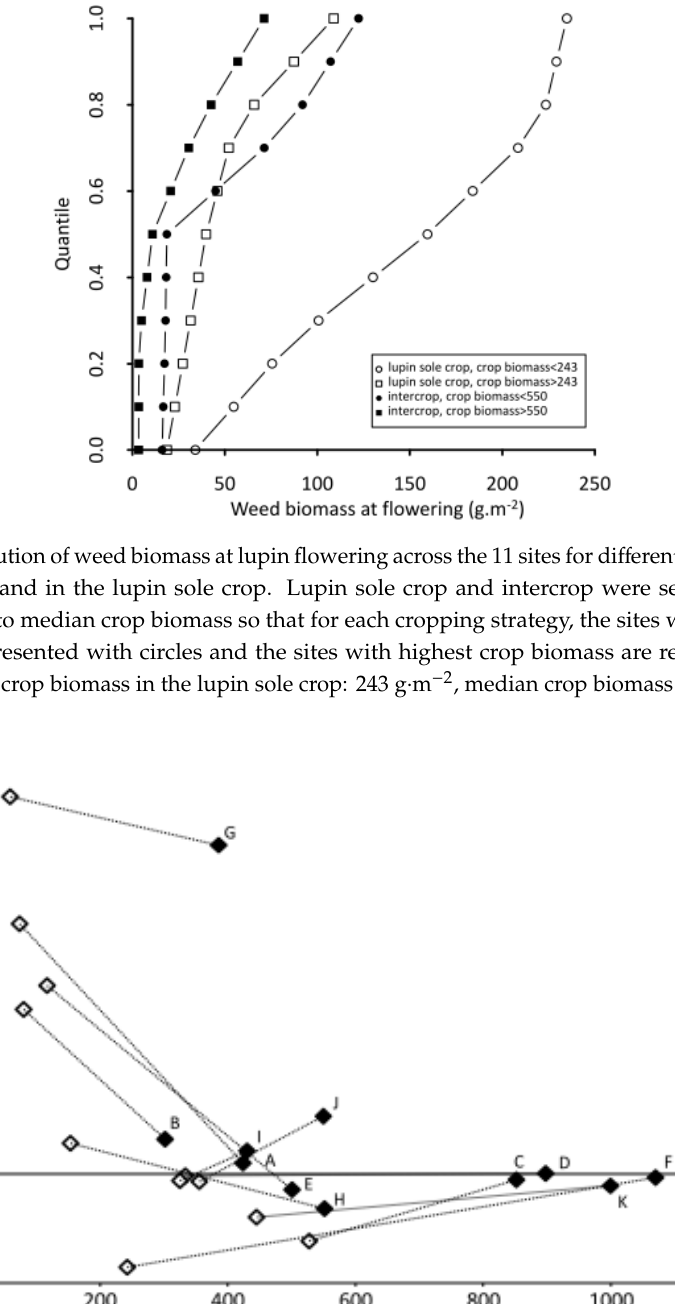
Figure 7. ( a ) Number of weed species in intercrops against number of weed species in lupin sole crops. ( b ) The percentage of dicotyledonous species in the total number of weed species in intercrops against the percentage in lupin sole crop. The dashed lines represent the theoretical situations with equal values in both cropping strategies. 3.2. Soil N Acquisition by Crops and Weeds before and after Flowering Soil N acquisition was very low in lupin sole crop at the beginning of the crop cycle. It reached only 2.5 g.m −2 at the beginning of lupin flowering. Crop mineral soil N acquisition until lupin flowering was enhanced by the addition of triticale: the average crop mineral soil N acquisition gain was +4.5 g.m −2 , i.e., +181%, Table 4). In the intercrop, triticale acquired 88% of the crop mineral soil N acquired by the mixture until flowering. Triticale biomass was on average 3 times higher than lupin biomass and triticale soil mineral N acquisition was on average 8 times higher than lupin soil mineral